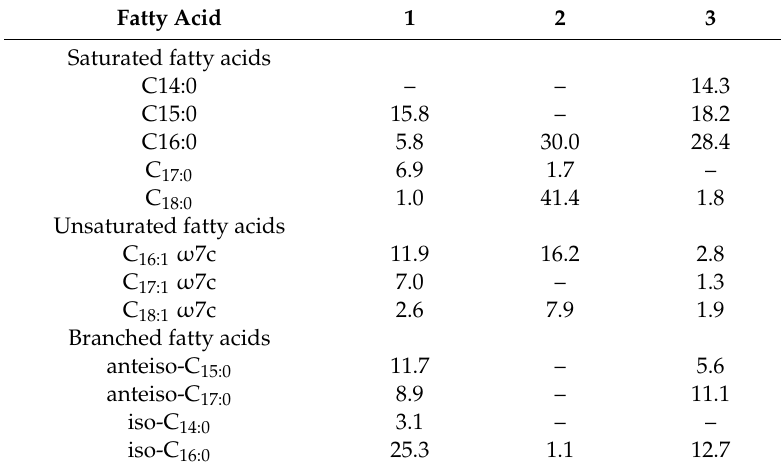
Table 2. The cellular fatty acid compositions of strain jys28 T and its closely related strains. Strains: 1, percentages of total fatty acids. Fatty acids representing < 1% in all strains were omitted. All data are from this study, and all strains were cultivated in ISP 2 broth for 5 days under. the same conditions. –, not